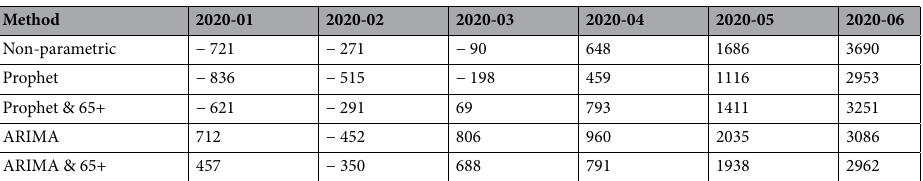
Table 2. The estimated excess mortality counts for the first six months of 2020 based on five previous years of historic data for different modeling approaches. Negative values indicate less than predicted counts.